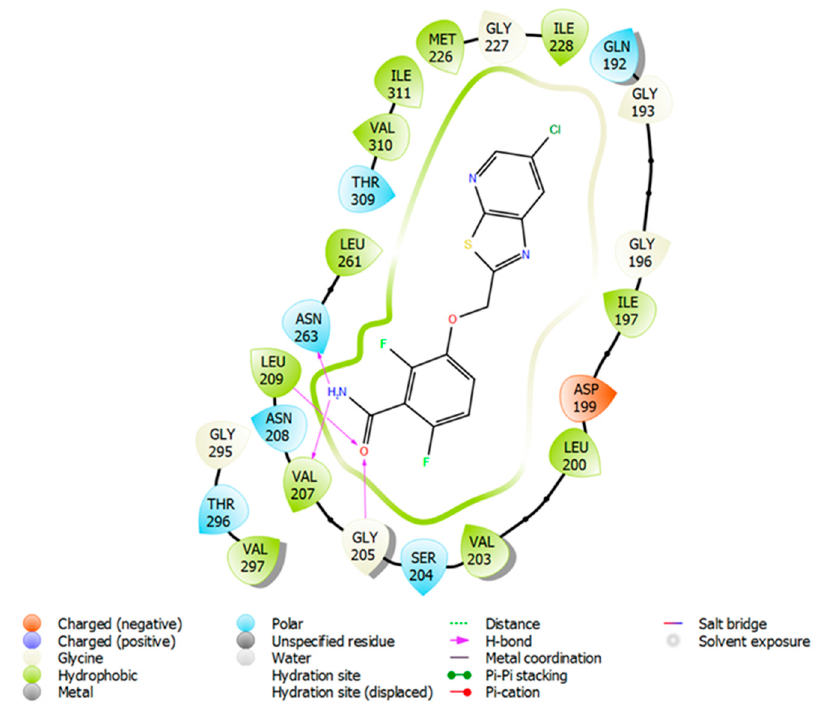
Figure 11. A 2D view of PC190723 4 docked into crystal structure of PC190723 4 bound to FtsZ (PDB ID 4DXD).